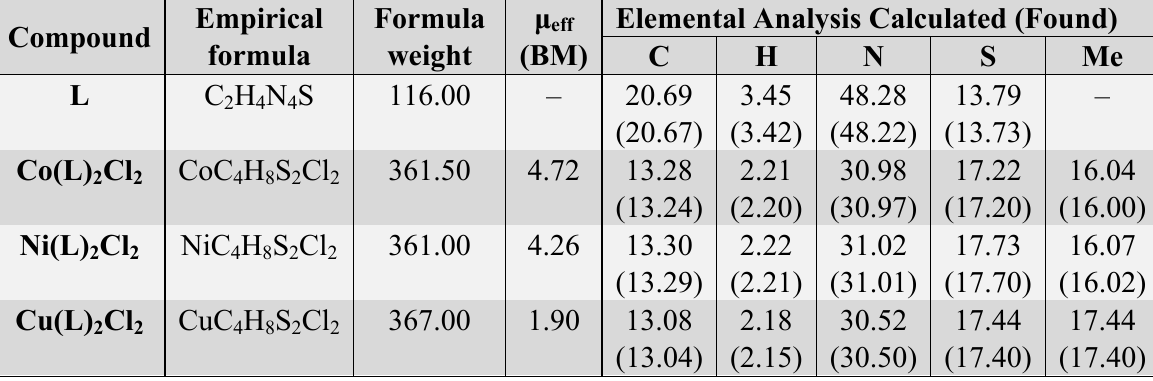
Table 1. Magnetic moment and elemental data of Ligand and their metal complexes.